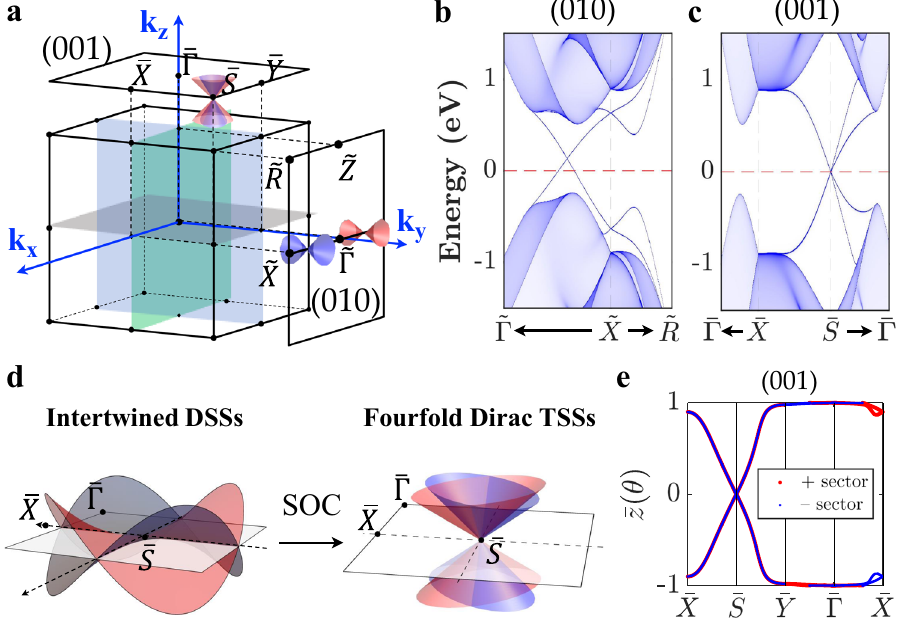
Fig. 2 Topological surface states and the evolution from DSSs to TSSs. a Brilliouin zones for the bulk, the projected (001) and (010) surfaces, on which the predicted positions of the fourfold Dirac fermion and Dirac cones are shown schematically. Surface band spectrum of the b (010) and c (001) surfaces along the high-symmetry k paths, where the fourfold Dirac fermion emerges at S on the (001) surface and a Dirac cone lies along the ~ Γ − ~ X direction of the (010) surface, respectively. d Schematic of the SOC-driven transition of the (001) surface states from the intertwined DSSs stemming from the CICE NLSM 37 (left panel) to the fourfold Dirac fermion at S of the TCI (right panel). e The z -directed Wilson loop along the high symmetry directions for occupied states hosting positive ( + sector, red) and negative ( − sector, blue) surface glide eigenvalues, indicating a bulk topology of ( χ x , χ y ) = (2, 2).